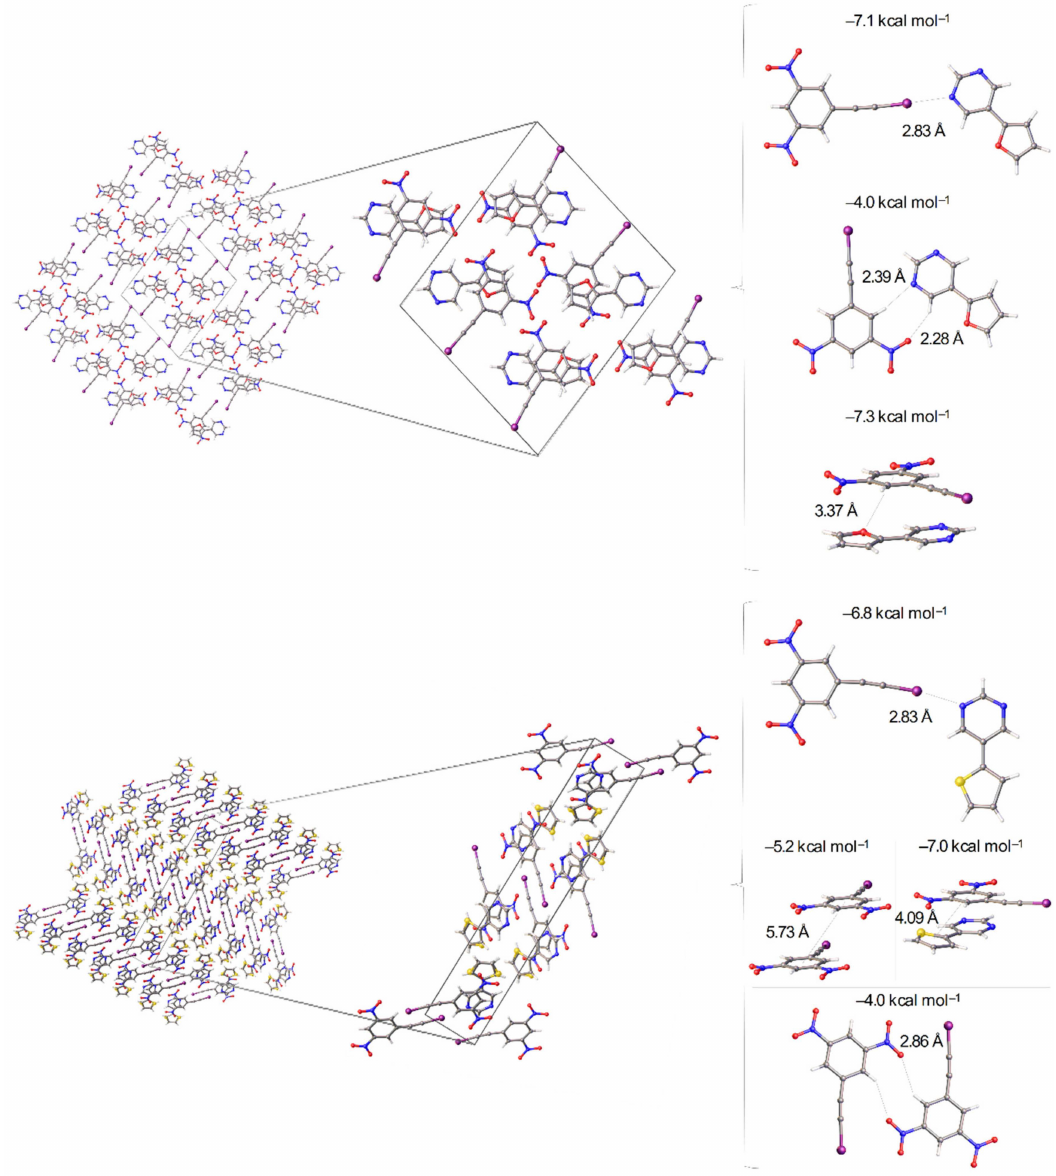
Figure 4. Halogen bond and weak hydrogen bonding interactions present in co-crystals formed from (NO 2 ) 2 BAI and PrmF (top) and PrmT (bottom). Details of the nearest neighbor interactions are included on the panel on the